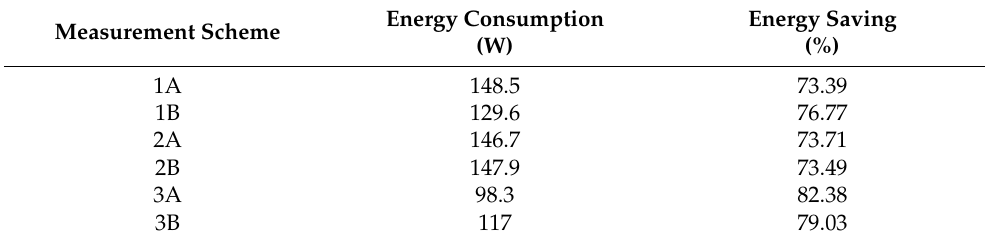
Table 5. The comparison of the energy